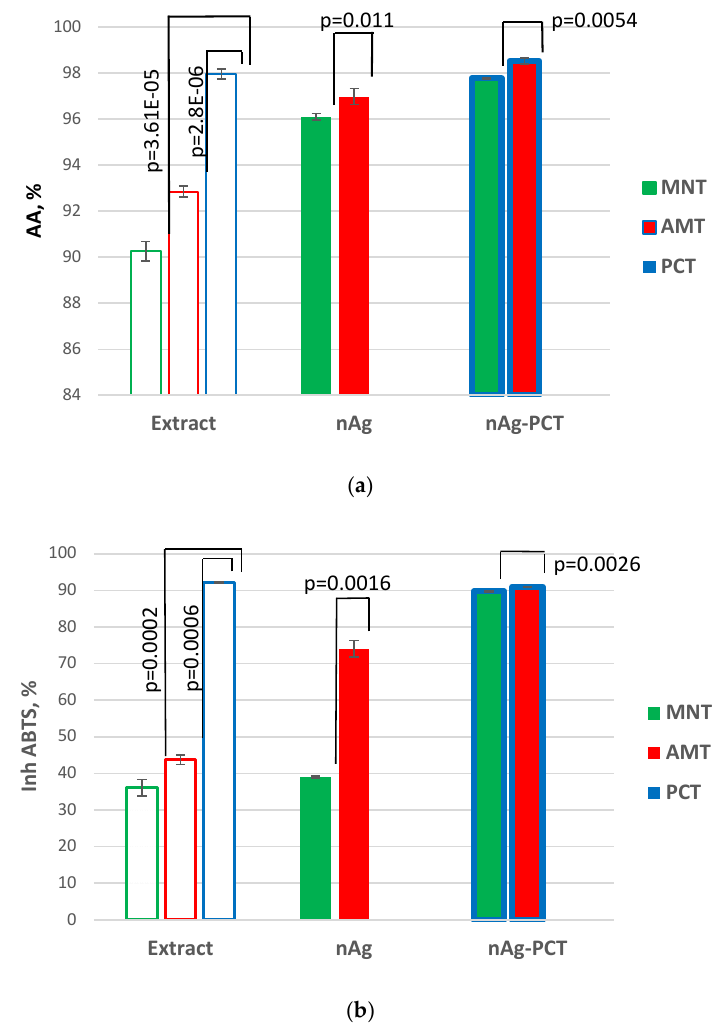
Figure 11. The antioxidant activity (AA%) of the samples evaluated by chemiluminescence technique ( a ) and inhibition of radical ABTS • + ( b ).